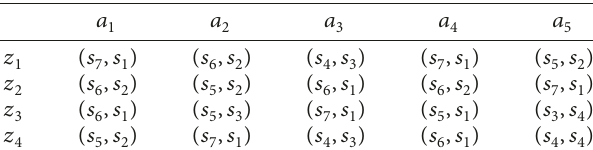
Table 9: Decision matrix R . 1